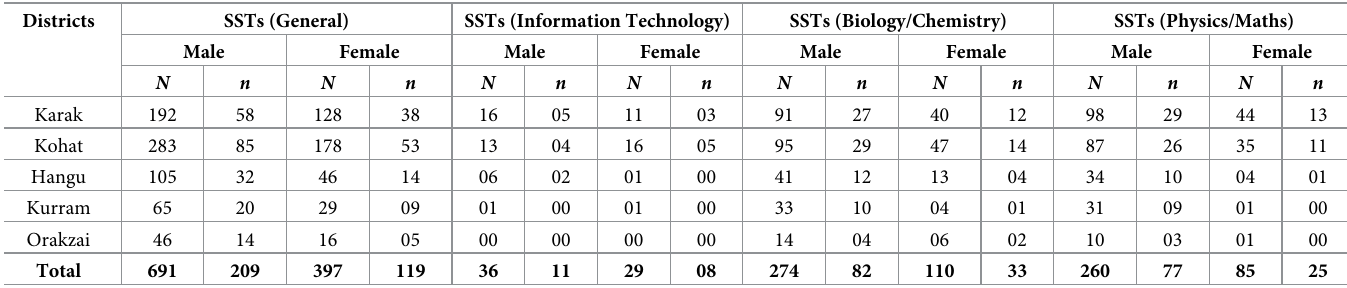
Table 1. Study population and sample